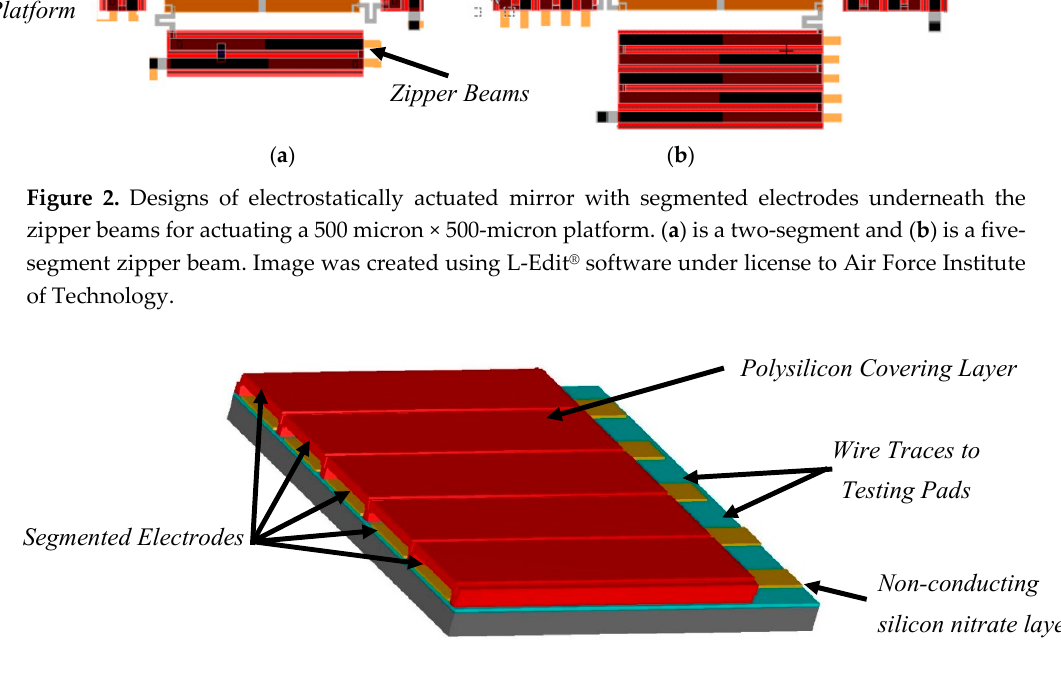
Figure 3. Three-dimensional cross-section model of five-segment electrode structure surrounded by cover to electrically isolate from actuating zipper beams. Image was created using L-Edit ® software under license to Air Force Institute of